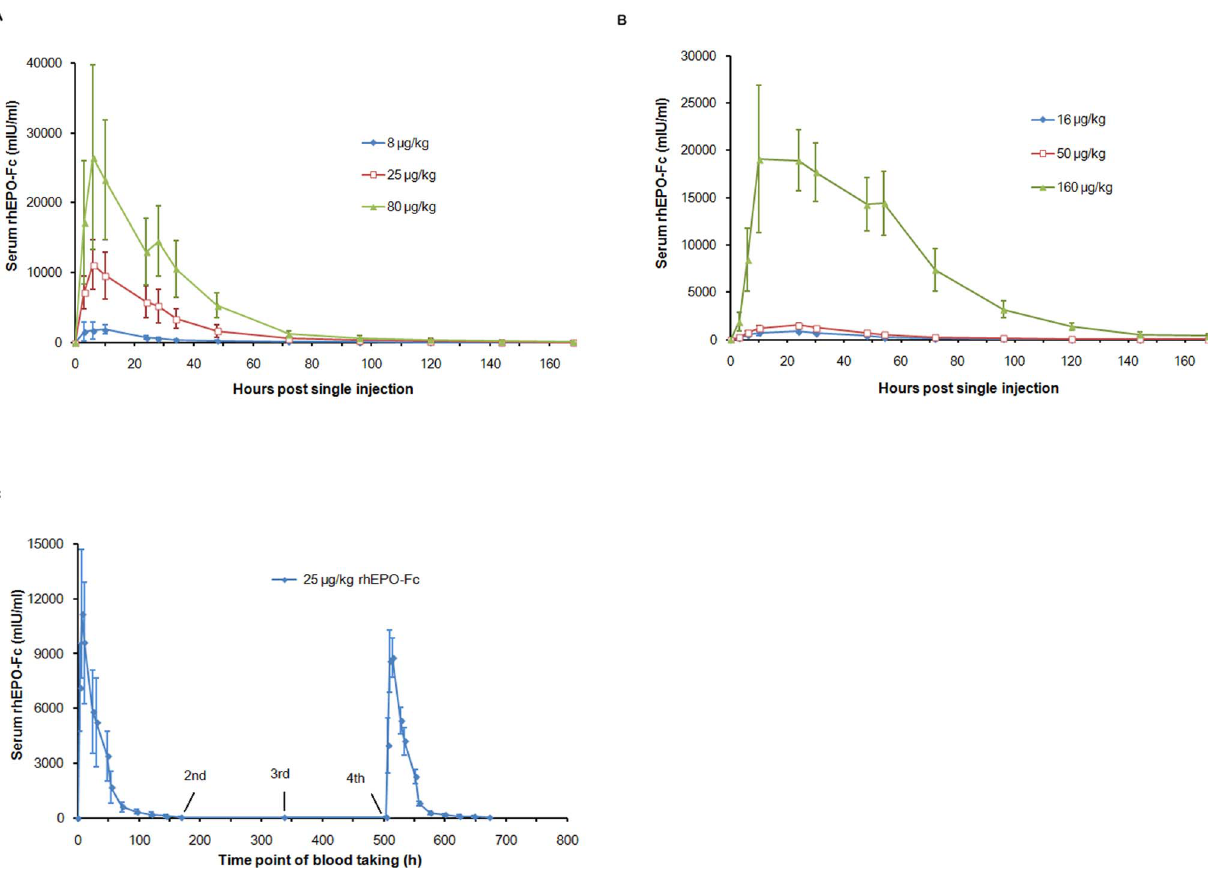
Figure 1. Pharmacokinetics of rhEPO-Fc with single and repeated injections. Mean serum rhEPO-Fc concentration versus time after single subcutaneous injection in rhesus monkeys (Fig. 1A), rats (Fig. 1B) and repeated subcutaneous injections in rhesus monkeys (Fig. 1C) were plotted. Data were mean 6 SD for six rhesus monkeys or twelve rats per group.